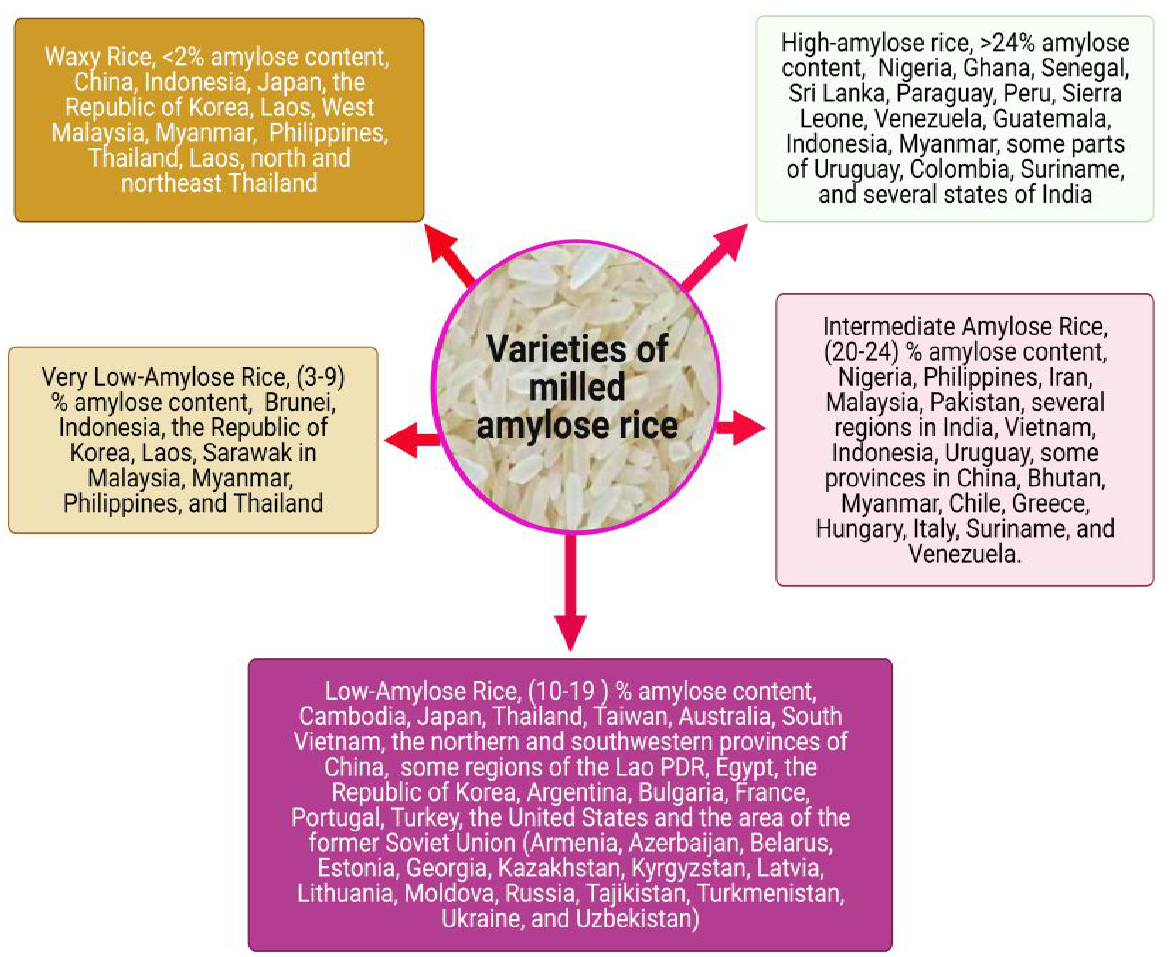
Figure 1. Varieties of amylose rice regionally preferred by different countries. Classification of milled rice based on amylose content and the list of countries that preferred different varieties of amylose rice (created with BioRender.com).